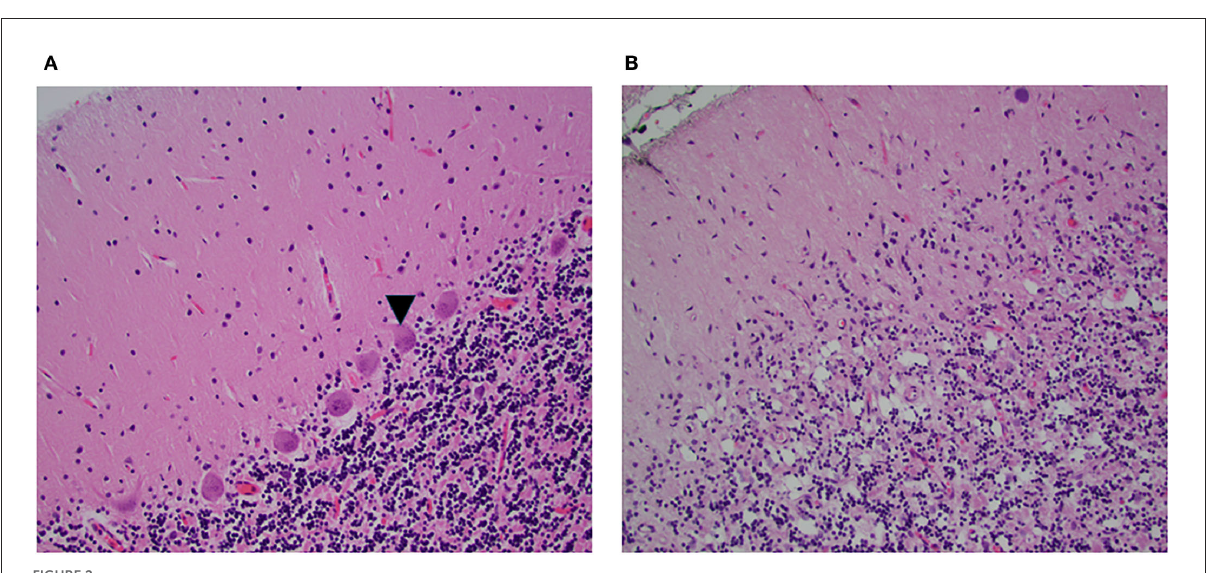
FIGURE2 Microscopic examination of the hemispheric cerebellar cortex. H&E x20. (A) Normal cerebellar cortex, the arrow points to morphologically intact Purkinje cells. (B) Similar section inpatient 1 shows absent Purkinje cells, note absent of acute inflammation. In this patient, the deep nuclei were